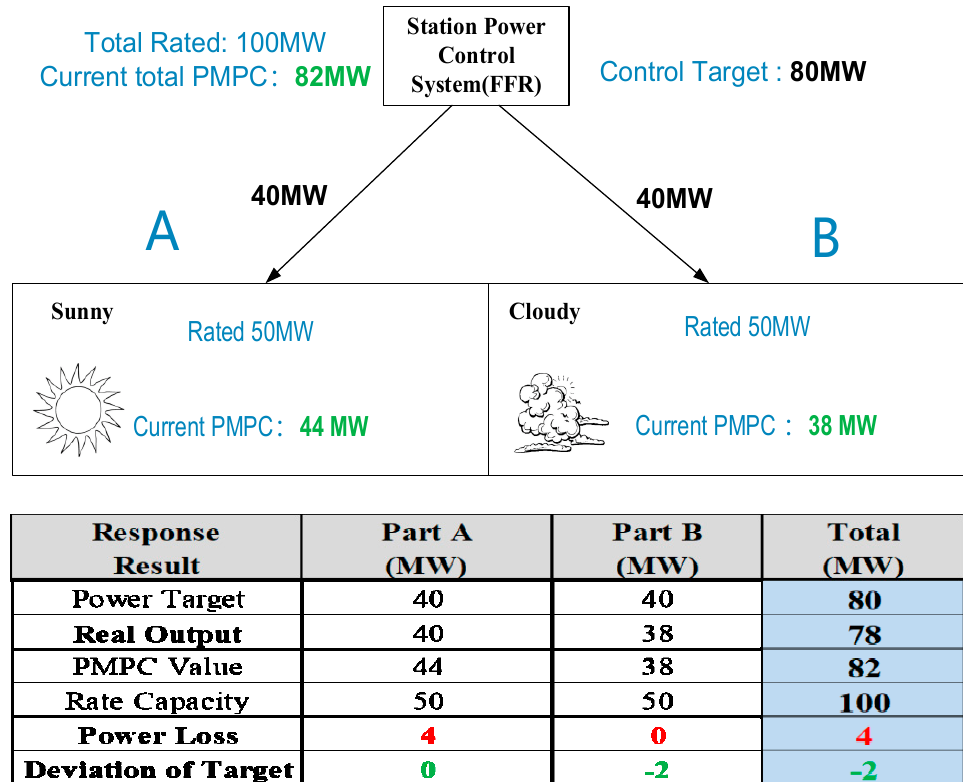
Figure 2. Power distribution effect of traditional average strategy.